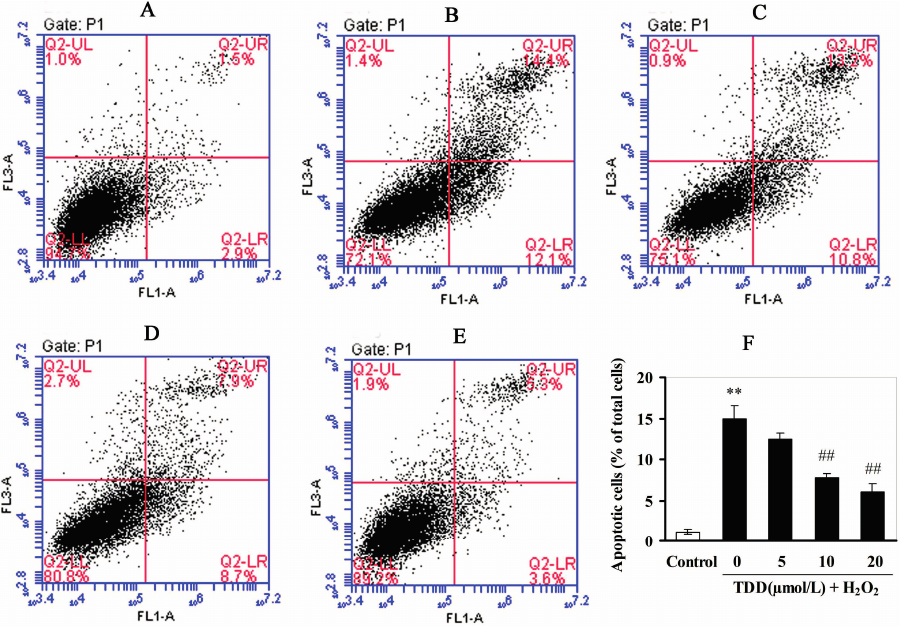
Figure 4. Effects of 2,4 ′ ,5 ′ -trihydroxyl-5,2 ′ -dibromo diphenylmethanone on H 2 O 2